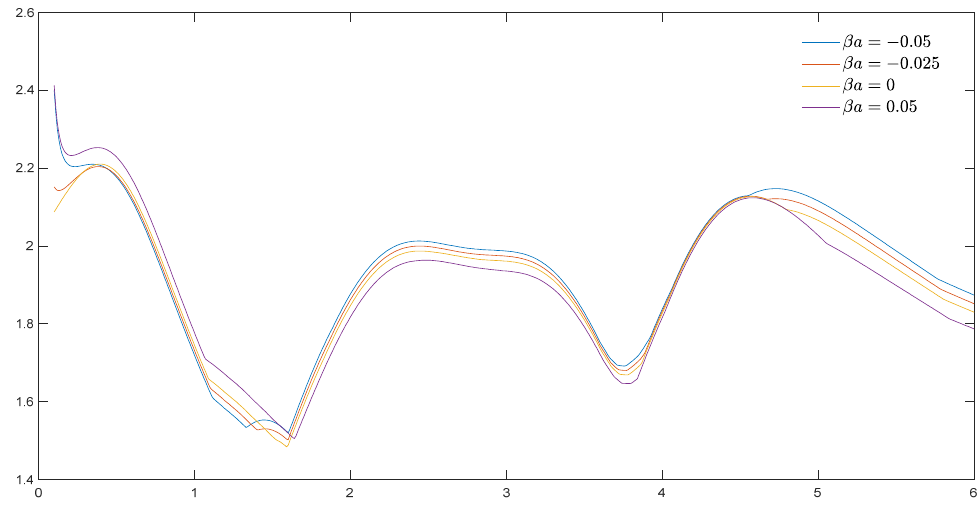
Figure 7. Polar graph of DSCF around the elliptical opening with ka = 4.0 and m = 1/6. Materials 2022 , 15 , x FOR PEER REVIEW